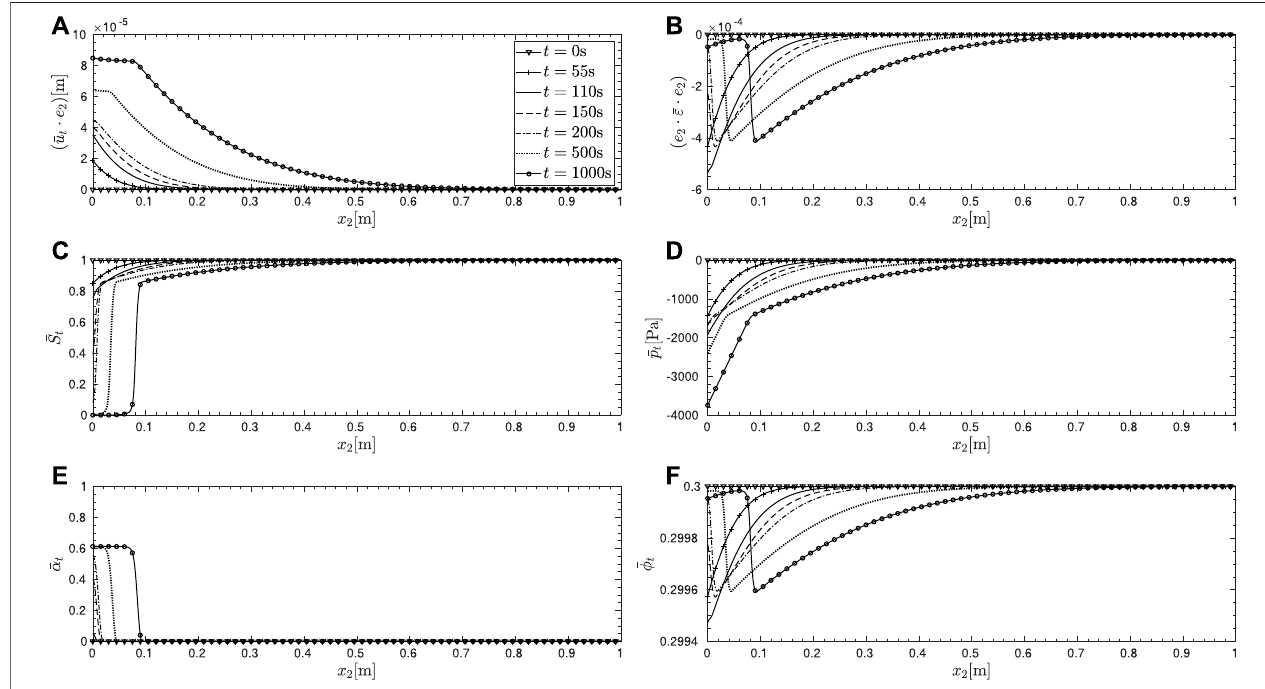
FIGURE 3 | Evolution of the one-dimensional base solution and functions of the solution within the full computational domain, ~ Ω (cid:2) ( 0 , 1m ) , for w 1 = 1000N.m − 3 .